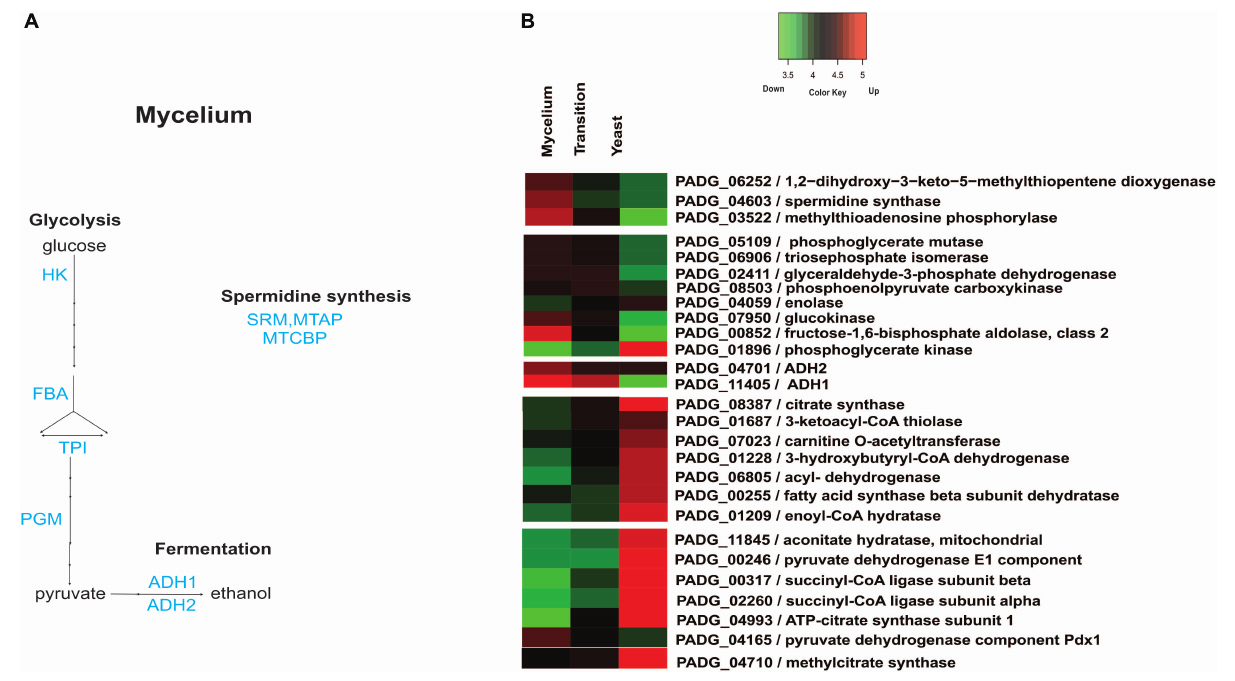
FIGURE 4 | Schematic diagram of the metabolic processes differentially expressed in mycelia and heatmap of proteins in mycelium, mycelium-to-yeast transition, and yeast cells. (A) The figure summarizes the data obtained from proteomic analysis; enzymes are listed as follows: HK, hexokinase; FBA, fructose-1,6-bisphosphate aldolase; TPI, triosephosphate isomerase; PGM, phosphoglycerate mutase; ADH 1 and 2, alcohol dehydrogenase; MTAP, methylthioadenosine phosphorylase; SRM, spermidine synthase; MTCBP, 1,2-dihydroxy-3-keto-5-methylthiopentene dioxygenase. (B) The color scale shows the mean of abundance of proteins obtained that were differentially expressed by the ANOVA test ( p -value ≤ 0.05). Functional categories were obtained by manual search in the annotation database Pedant (http://pedant.gsf.de/) on MIPS that provides a tool to search the Functional Categories (Funcat 2.0). Red represents significantly higher expression and green represents a significantly low level of